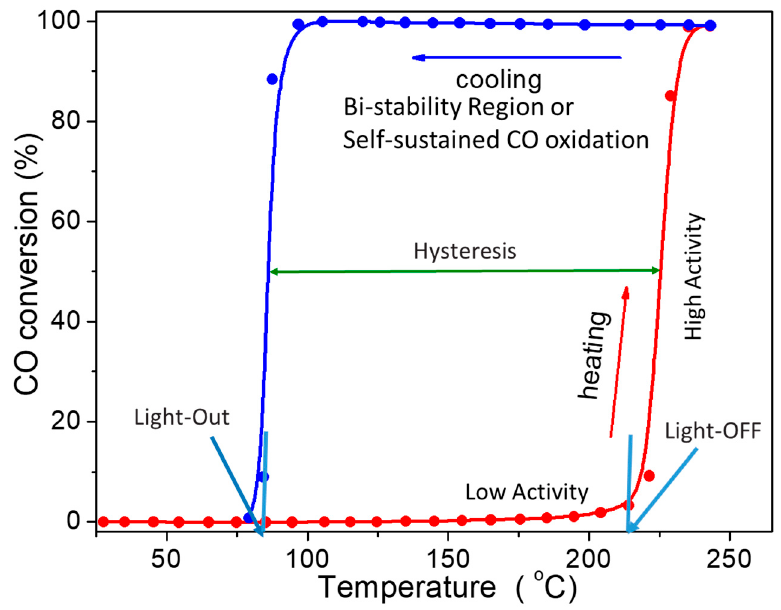
Figure 1. Typical hysteresis can occur during ignition (light-off) and extinction (light-out) exothermic CO oxidation reaction.